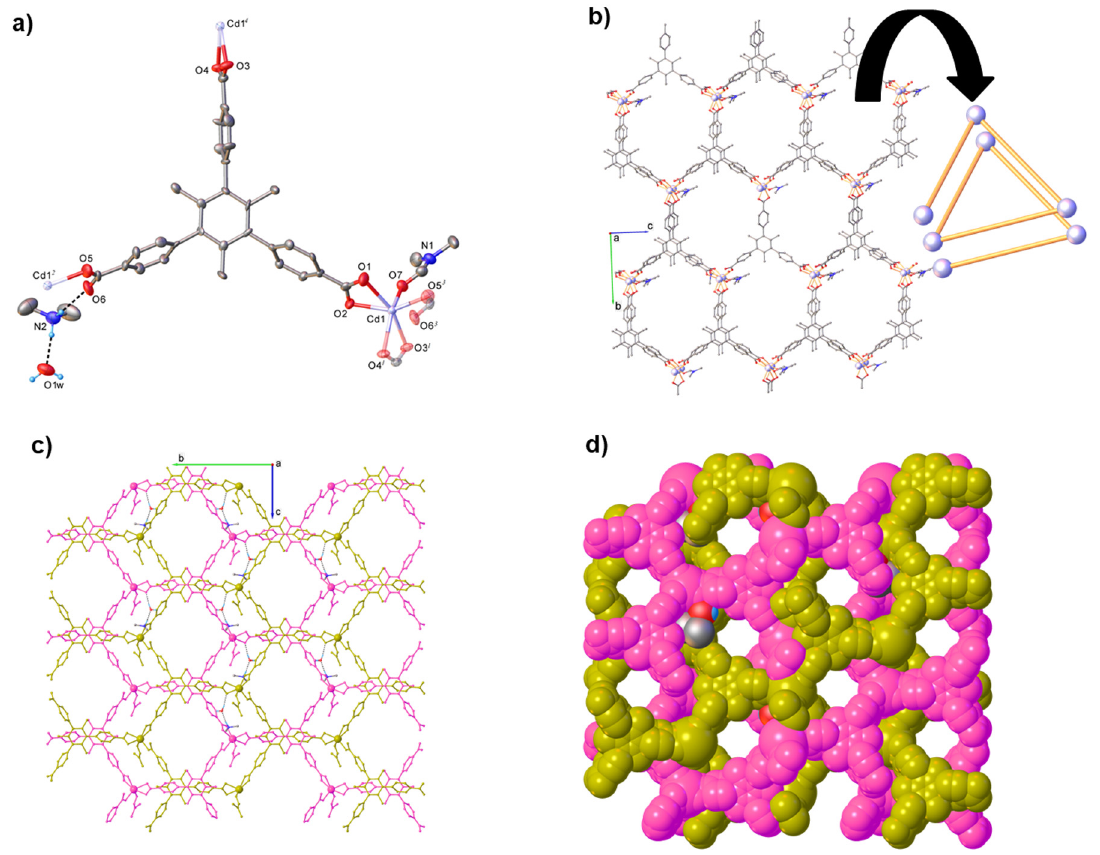
Figure 2. Crystal structure of compound 2 . ( a ) View of the asymmetric unit with thermal ellipsoids at 50% level and selected atom labeling showing the coordination of the Cd atoms. Symmetry-generated atoms are shown with faded colors; ( b ) View of the 3D coordination polymer, helical chain array of Cd atoms along a -axis (enclosed); ( c ) Crystal packing viewed along the a -axis; ( d ) Space-filling model. Non-relevant H-atoms are not shown. Symmetry codes: 1 ) 5/4 − x , y − 1/4, z − 1/4; 2 ) 3/4 − x , ¼ + y , z − 1/4; 3 ) ¾ − x , y − 1/4, ¼ + z ; 4 ) 5/4 − x , ¼ + y , ¼ + z .